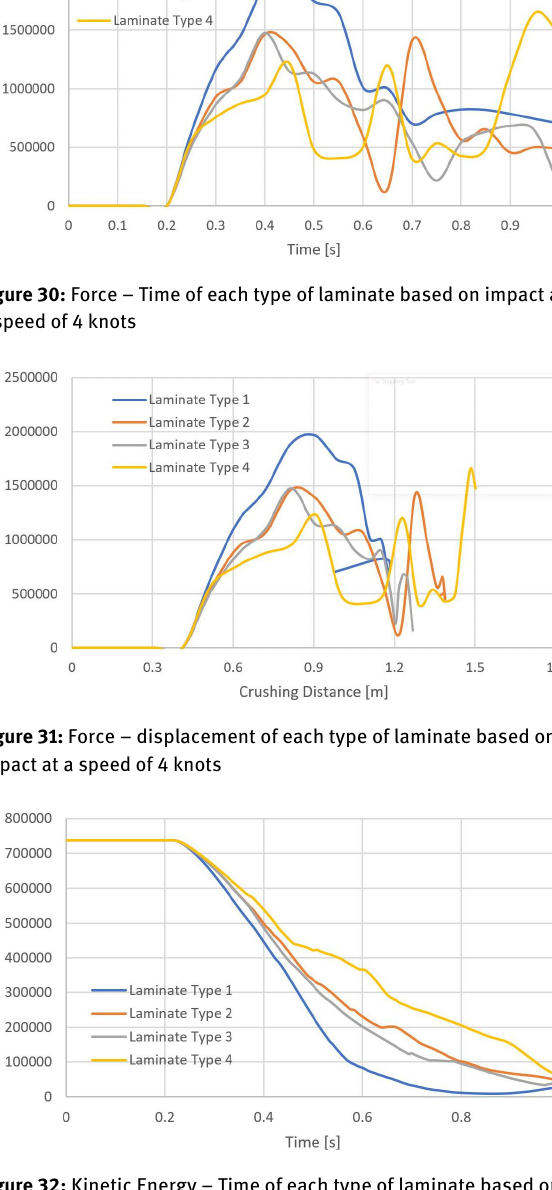
Figure 32: Kinetic Energy – Time of each type of laminate based on impact at a speed of 4